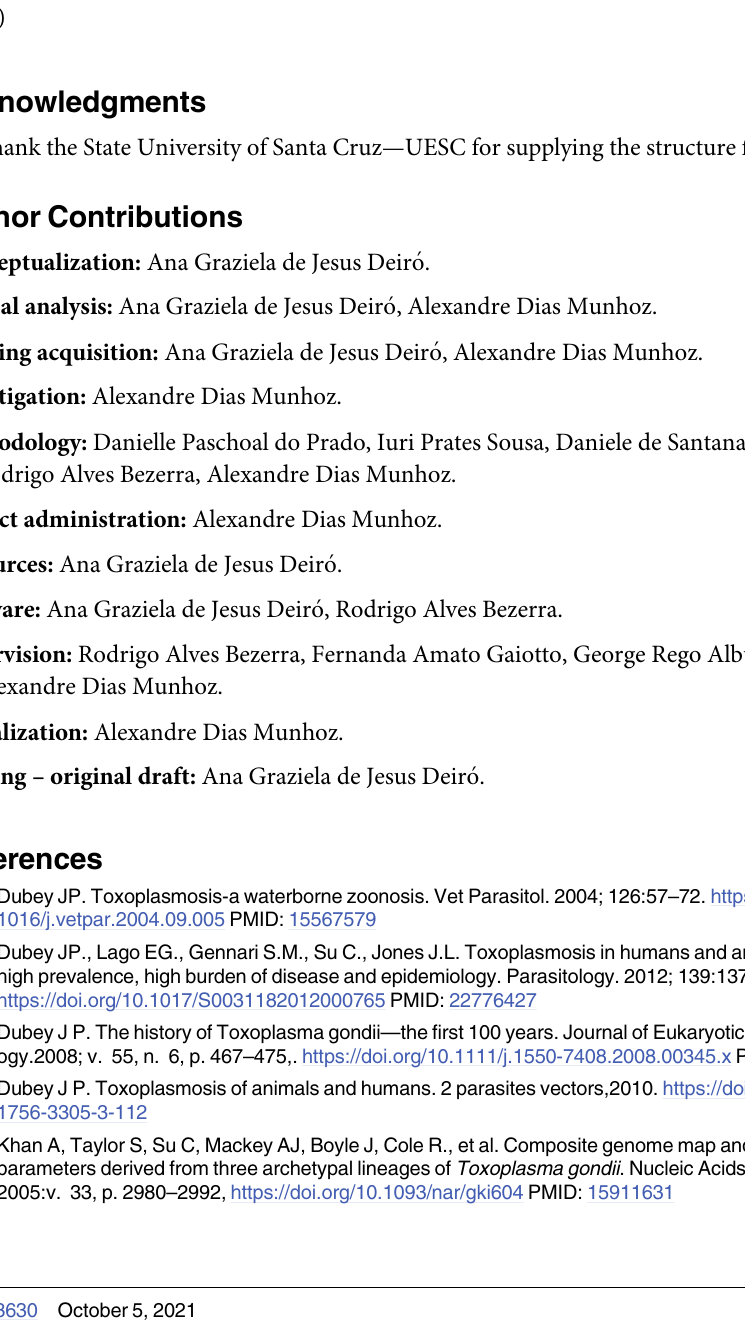
S3 Table. Different T . gondii genotypes using PCR-RFLP in Bahia, Brazil. u-1, u-2 –atypical alleles; Nd -not determined. S4 Table. Genotyping by MS of Toxoplasma gondii isolates from cats in Bahia-Brazil and compared to isolates from other studies. Three archetypal reference strains (ENT, ME49 and NED) are included. � bold atypical